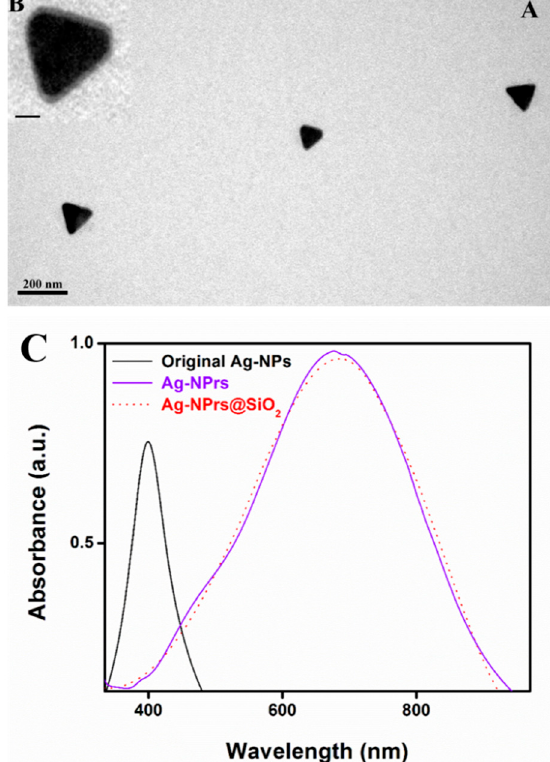
Figure 9. ( A ) TEM image of silica coated Ag-NPrs with a silica shell from 3–6 nm, ( B ) inset with the HR-TEM image of silica coated Ag-NPrs (inset scale bar 50 nm). ( C ) The UV-vis spectra of the Ag-NPs, Ag-NPrs, and Ag-NPrs@SiO 2 at two different wavelengths (400 and 750 nm, respectively).